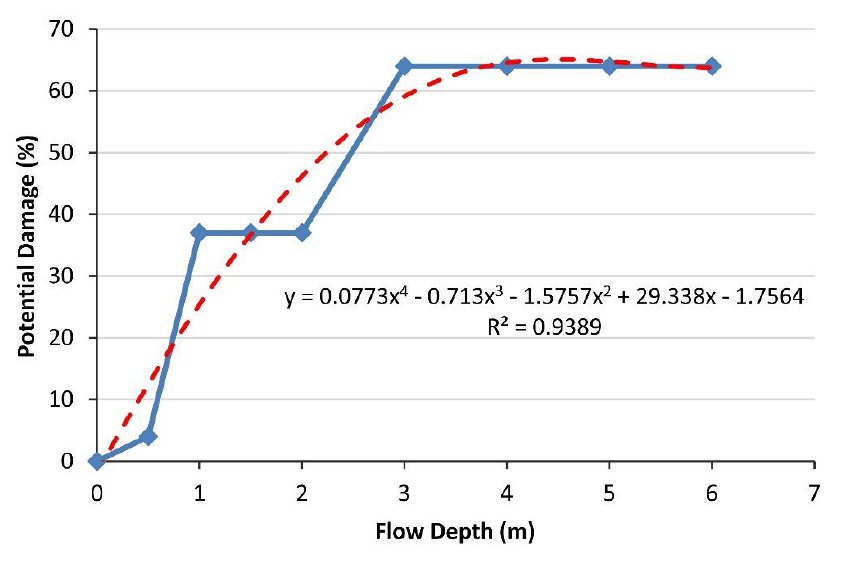
Figure 4. Switzerland magnitude–damage model for river flooding, showing its characteristic staggered shape.